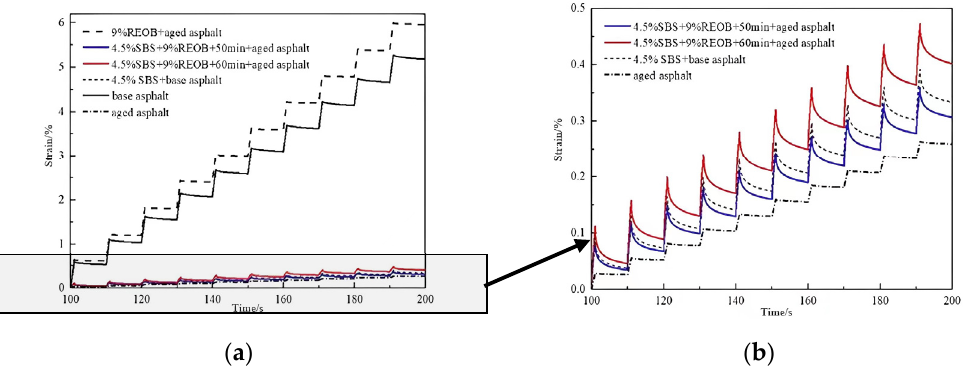
Figure 1. MSCR test results at 0.1 kPa stress level: ( a ) Test results of each asphalt; ( b ) Test results of aged asphalt, 4.5% SBS + 9% REOB + 50 min + aged asphalt, 4.5% SBS + 9% REOB + 60 min + aged asphalt and 4.5% SBS + base asphalt.